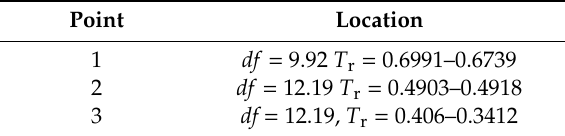
Table 2. The location of the multiple points shown in Figure